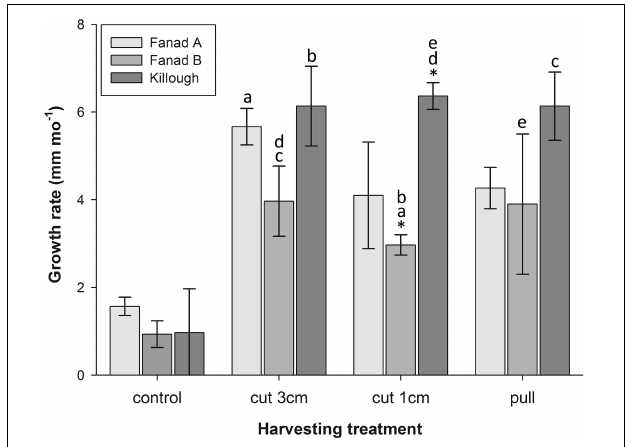
FIGURE 4 | Mean growth rates (mm mo − 1 , ± SD) of coralline algae harvested by three different methods, and controls in three different pools over the duration of the experiment (10 months). Growth rates of control samples were significantly different from all others. ∗ Indicates isolated difference in growth rate within an experimental harvesting treatment group; letters indicate significant differences between pairs of growth rates across different treatments and pools ( post hoc Tukey’s HSD p < 0.05).